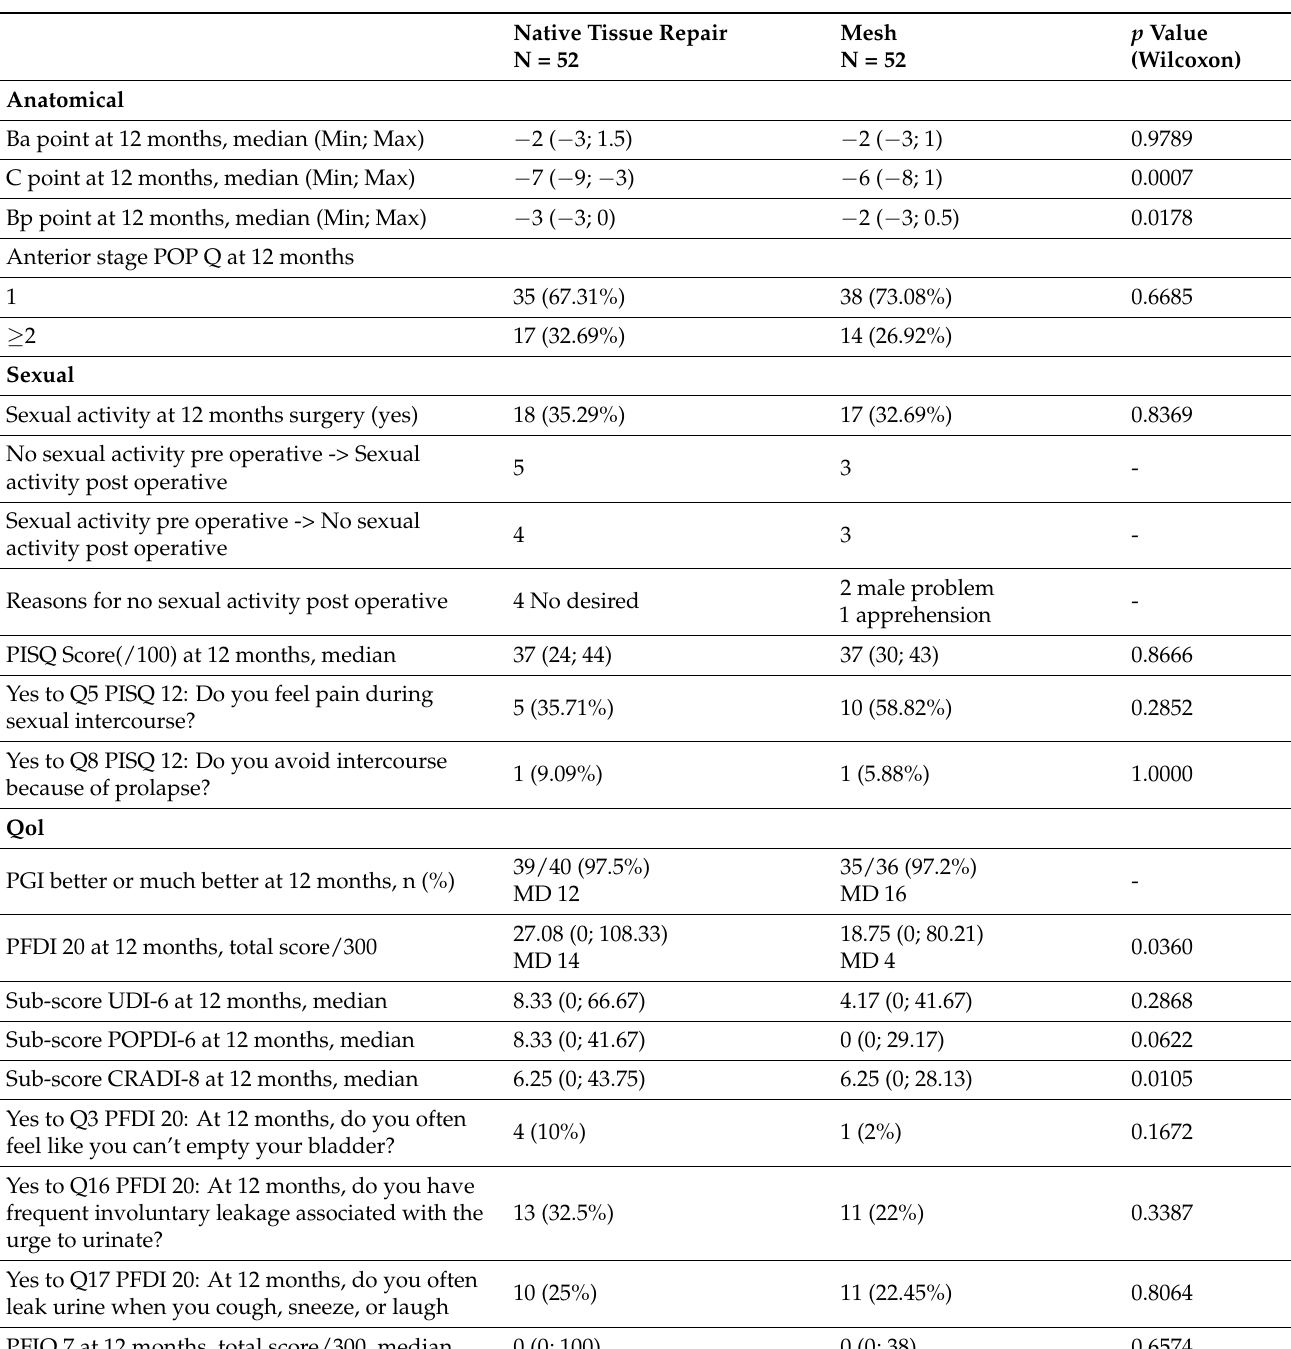
Table 2. Postoperative anatomical and functional